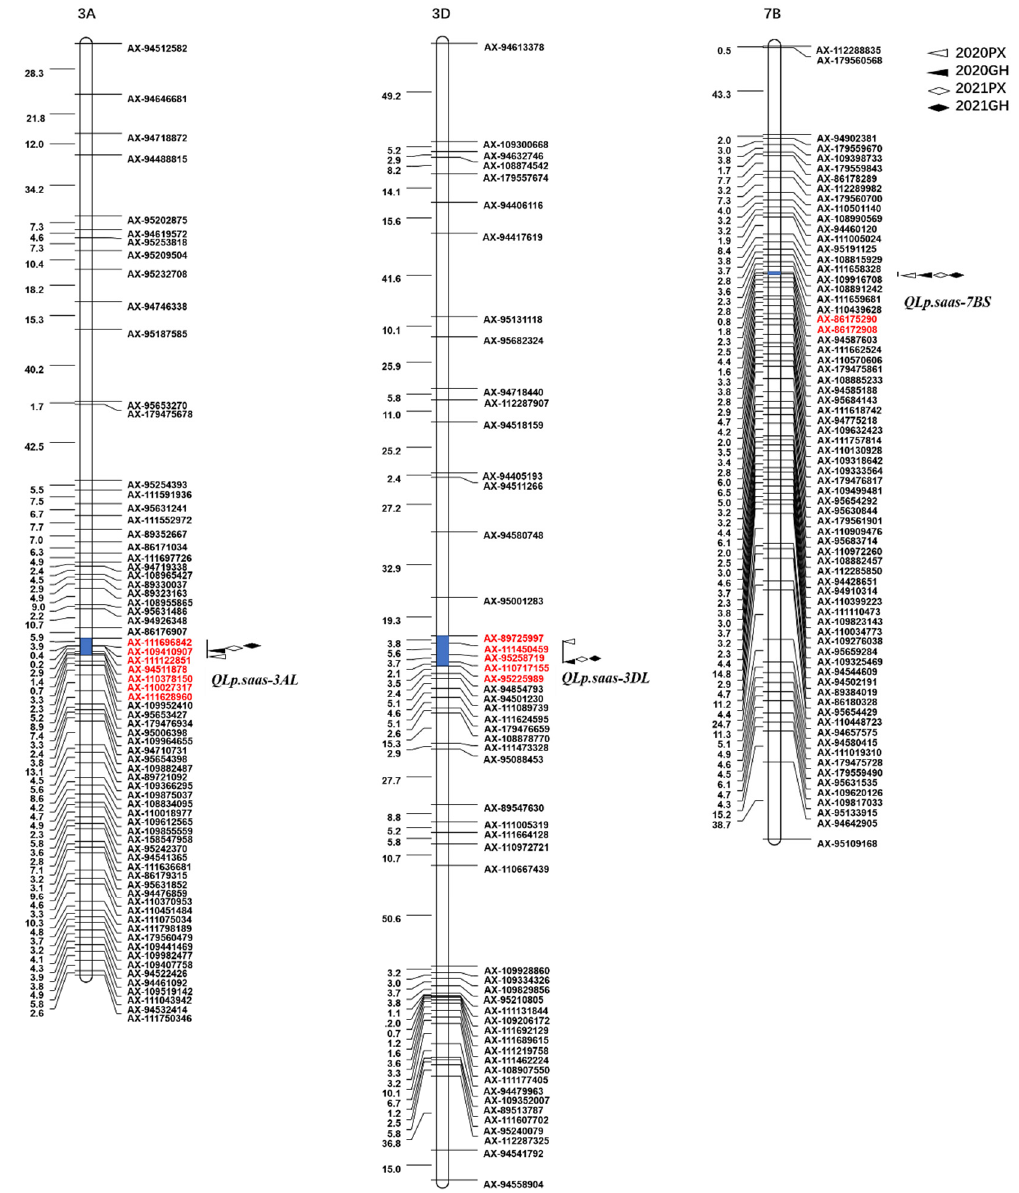
Figure 2. Mapping of QTLs associated with leaf pubescence in the CM104 × BMM recombinant inbred lines population grown in four environments; 2020PX, 2021PX, 2020GH, and 2021GH represent the four environments: Pixian in 2020, Pixian in 2021, Guanghan in 2020, and Guanghan 2021, respectively. Table 2. QTLs for leaf pubescence by inclusive composite interval mapping in the recombinant inbred lines population of Chuanmai104 × Baimaomai in four environments. The physical position of markers is in relation to the Chinese Spring reference genome (IWGSC RefSeq v2.1).